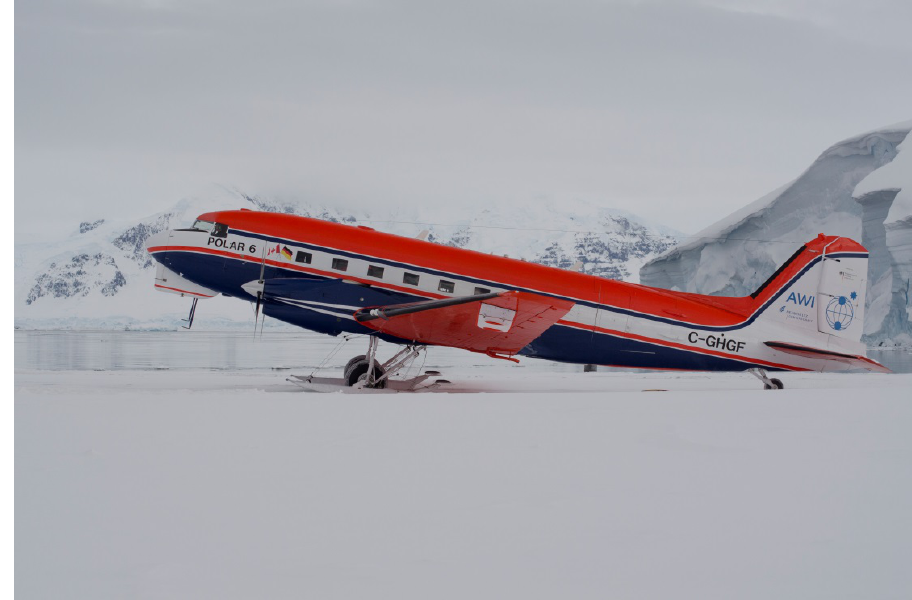
Figure 1: Polar6, Photo: Alfred-Wegener-Institut/R.